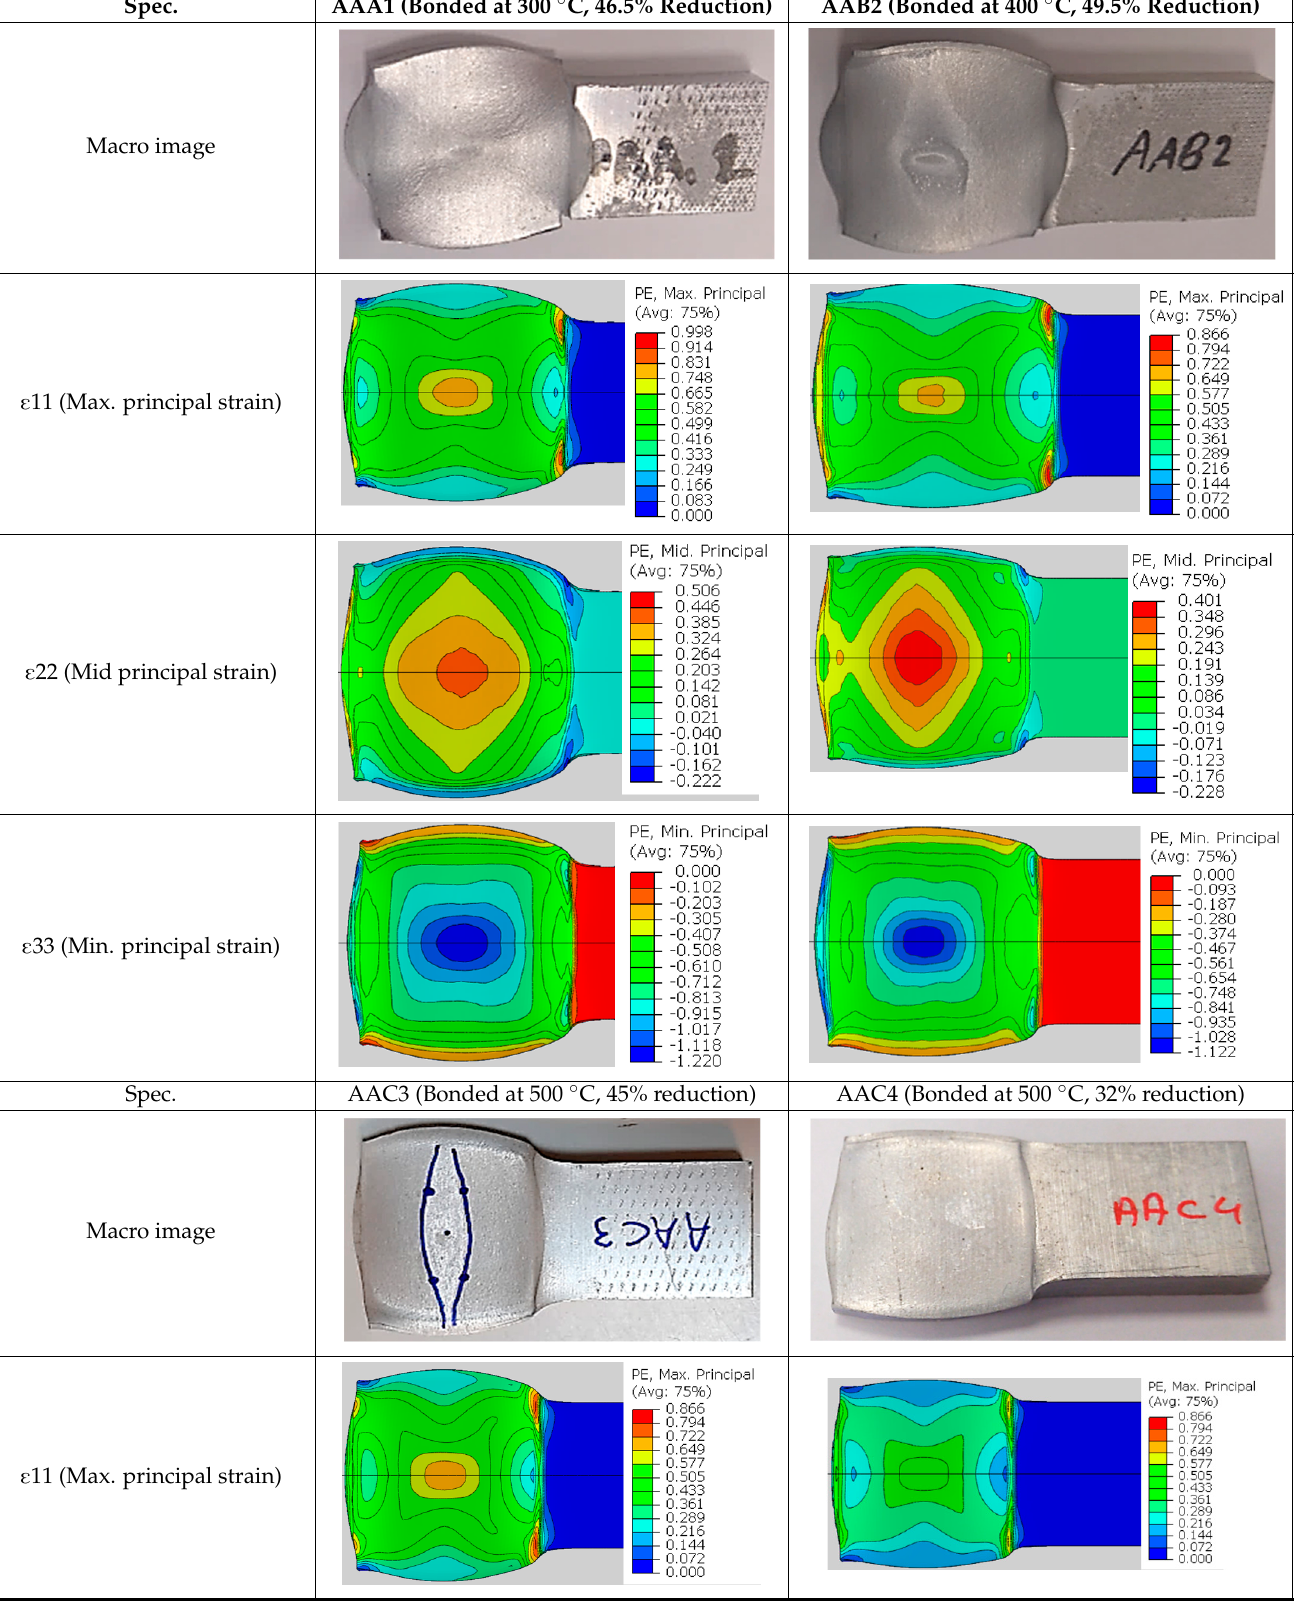
Table 5. Mechanical fields from FE models of the bonding interface when reaching the specimen’s final reduction. Spec.